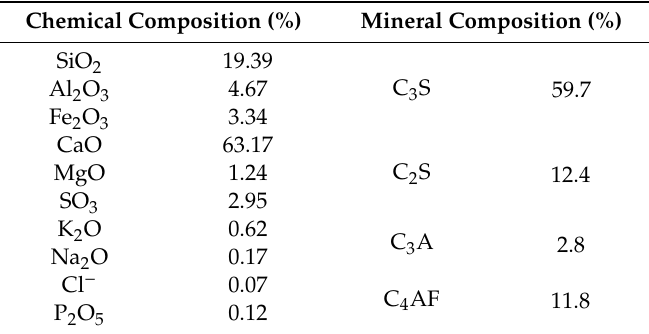
Table 2. Chemical and mineral composition of cement.